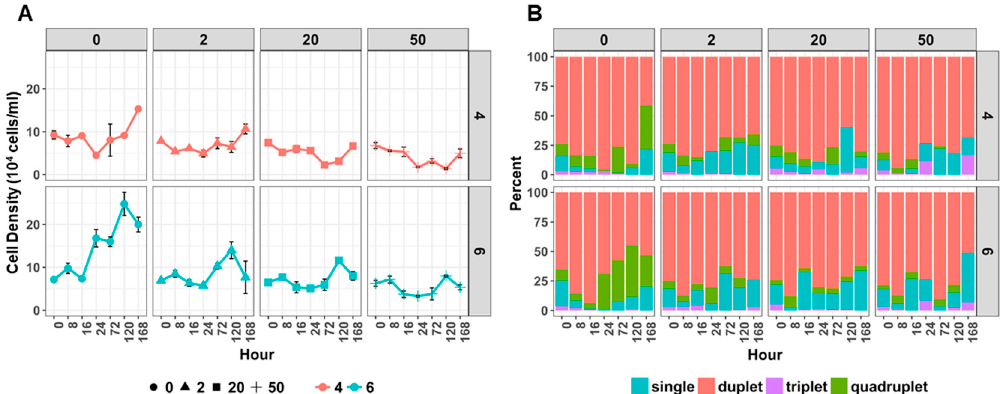
Figure 1. The e ff ects of copper and pH on cell density and the percentage of number of cells per colony Figure 1. The effects of copper and pH on cell density and the percentage of number of cells of Desmodesmus sp. AARLG074. ( A ) The mean cell density of Desmodesmus sp. AARLG074 grown at per colony of Desmodesmus sp. AARLG074. ( A ) The mean cell density of Desmodesmus sp. pH 4 (red line) and pH 6 (blue line) and copper concentrations (0, 2, 20, 50 mg / L) over 168 h. ( B ) The AARLG074 grown at pH 4 (red line) and pH 6 (blue line) and copper concentrations (0, 2, mean percentage of single (blue), duplet (pink), triplet (purple) and quadruplet (green) cells per colony of Desmodesmus sp. AARLG074 growing at pH 4 and pH 6 and copper concentration over 168 h. Values are mean ± SD ( n =